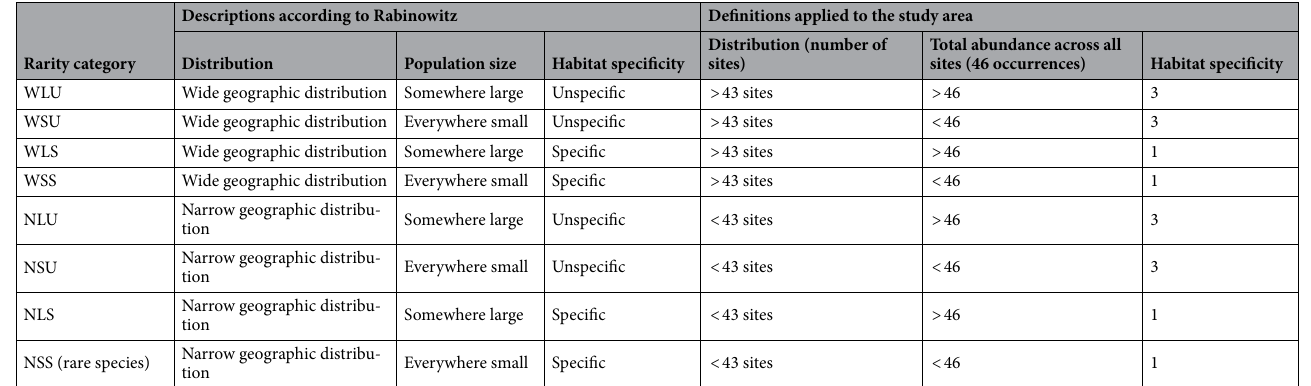
Table 1. Rabinowitz’s (1981) categorical classification of the seven forms of rarity for species, based on species abundance, distribution and habitat specificity. Within Booderee National Park, a total of 86 sites were surveyed, and species abundance ranged from one to 92 occurrences within a site. The number of habitats indicates how many vegetation communities out of the three different vegetation communities surveyed the species was present